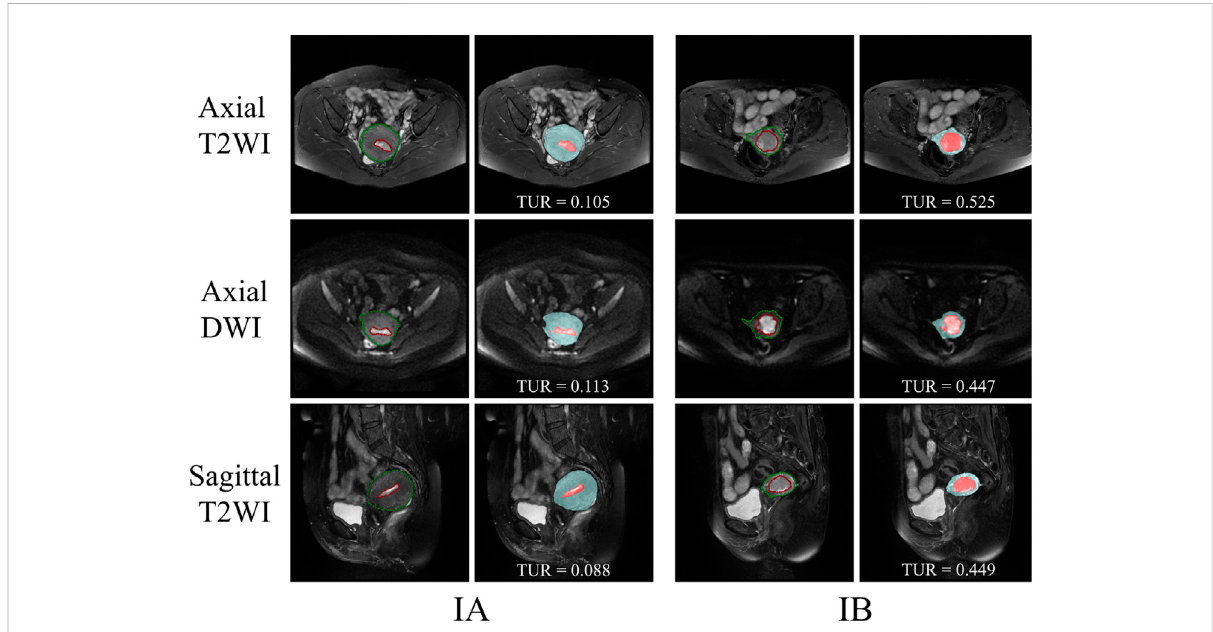
FIGURE 5 The segmentation results of a patient with EC stage IA (left) and a patient with stage IB (right) on axial T2WI image, axial DWI and sagittal T2WI image.Theredoutlineistheground-truthofthetumorandthegreenoutlineistheground-truthoftheuterus.Theredareaisthetumorandtheblue area is the uterus.